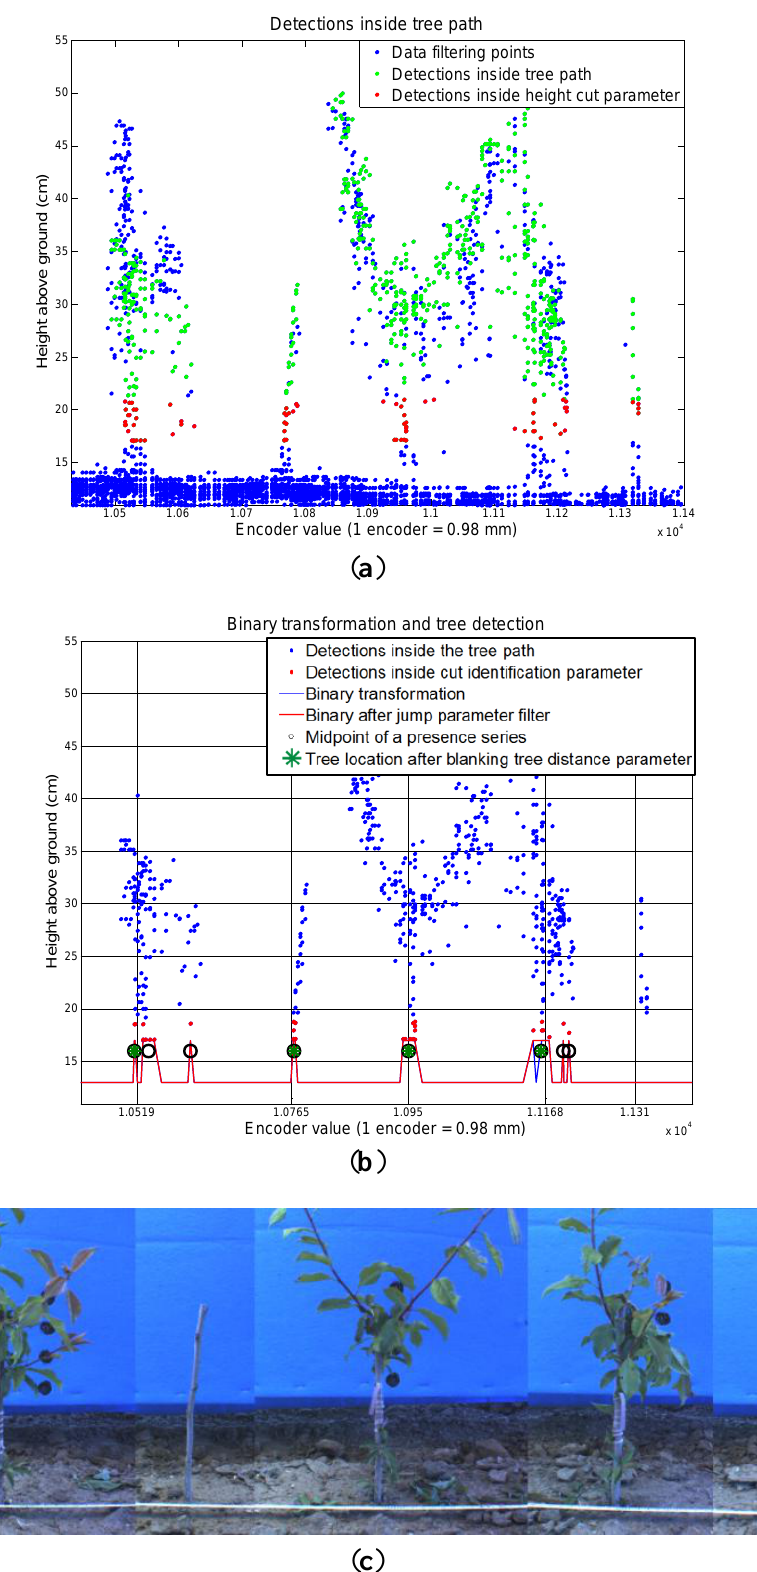
Figure 7. Methodology used for tree stem identification from the LIDAR detection data. In the graph on the right, the x-axis grid shows the actual location of the trees (the last one was not detected). The image shows the corresponding view of the scanned